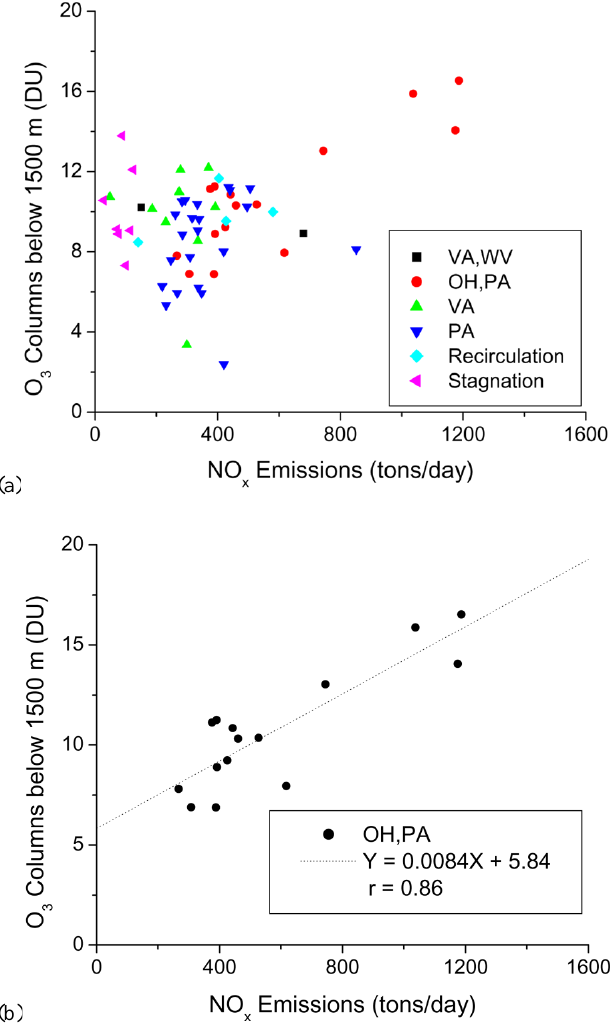
Fig. 13. RAMMPP column O 3 abundance versus CEMS emissions of NO x : (a) all clusters; (b) OH/PA cluster only for which linear re- gression of column O 3 vs. CEMS emissions of NO x was conducted (slope, intercept, and regression coefficient